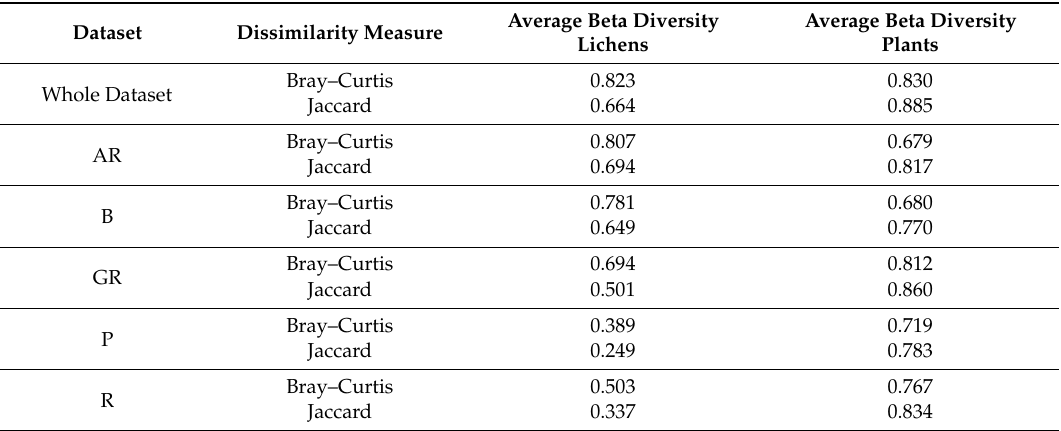
Table 5. Mean beta diversity measures calculated for plants and lichens, separately. AR—Shrublands, B—Riparian woods, GR—Dry Banks, P—Swamps, R—Flooded Banks.